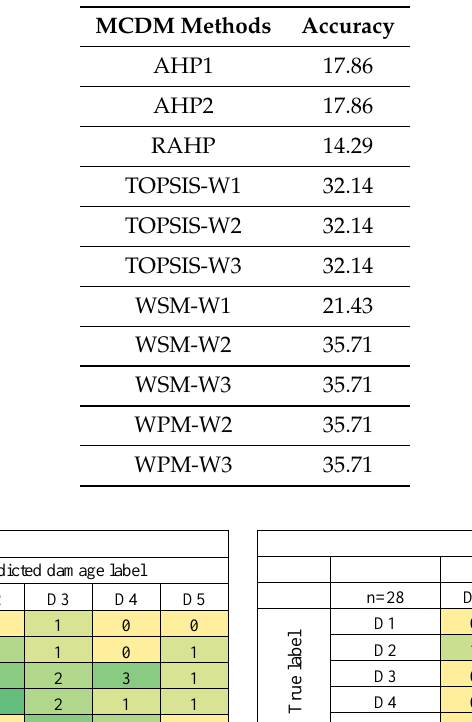
Table 16. Percentage of accuracy achieved from confusion matrices.